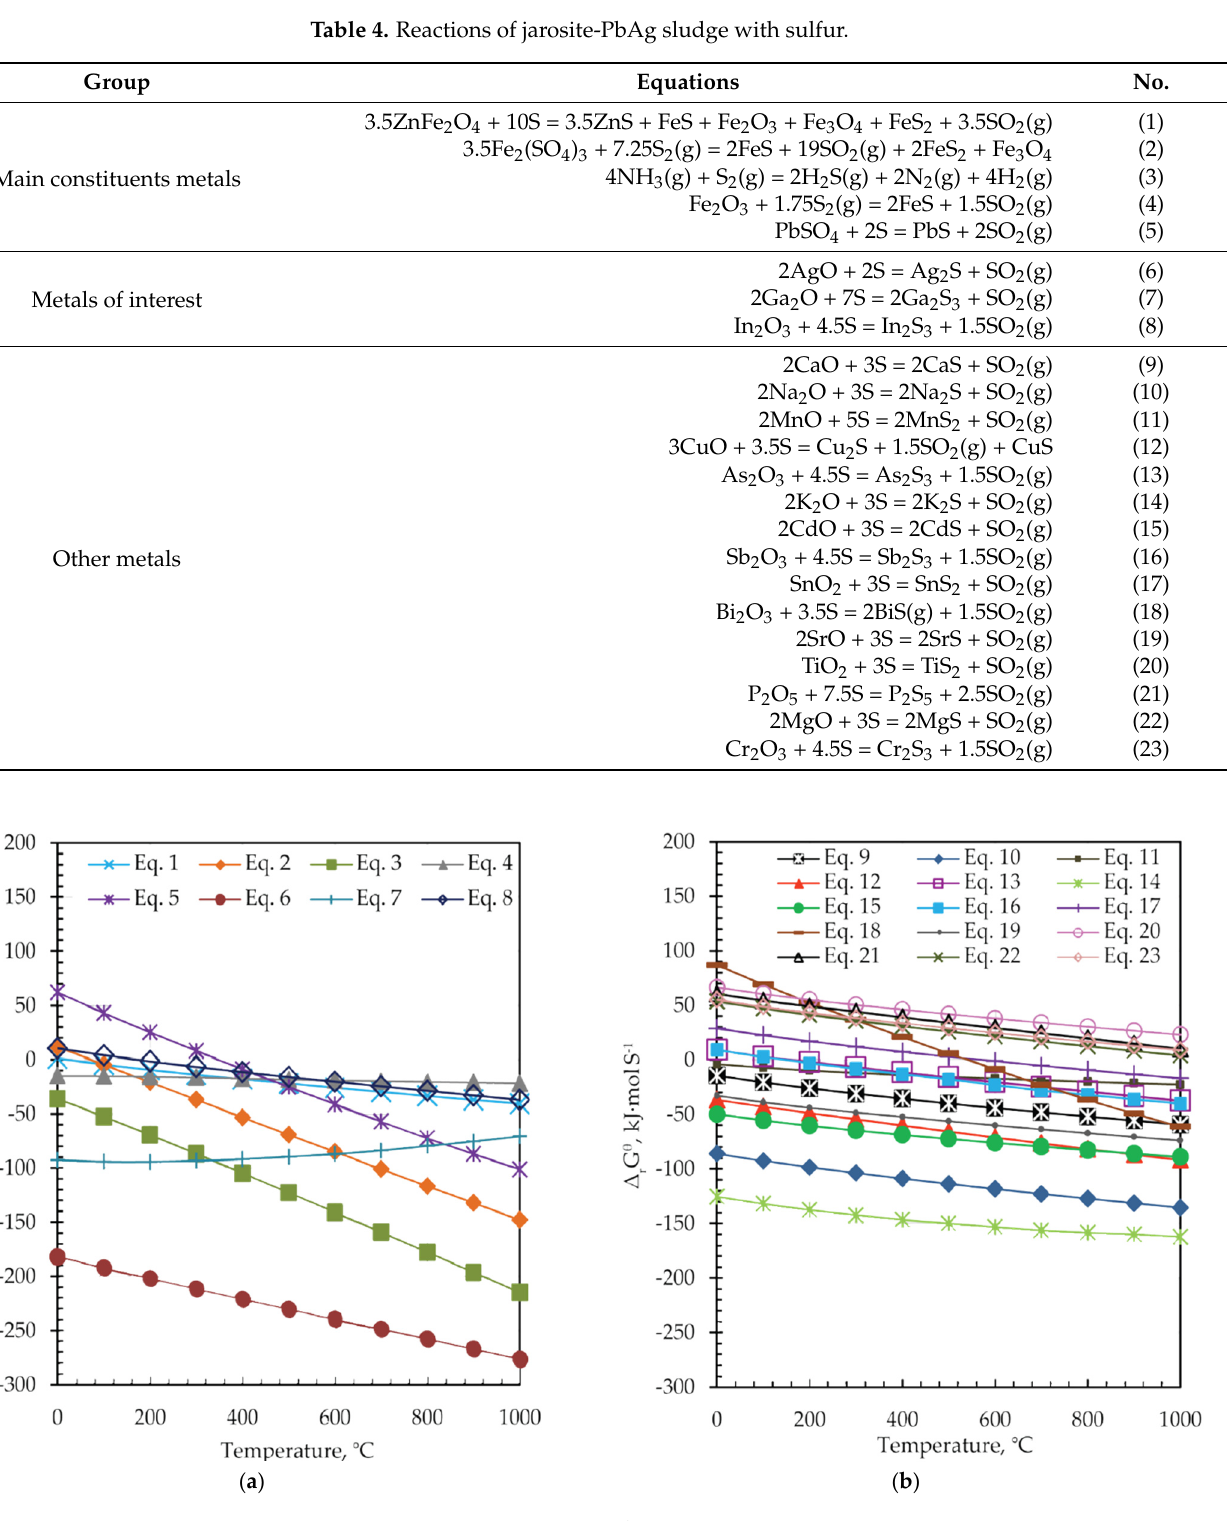
Figure 7. The change in standard Gibbs free energy ( Δ r G θ ) versus temperature for ( a ) Equations (1)–(8) and, ( b ) Equations